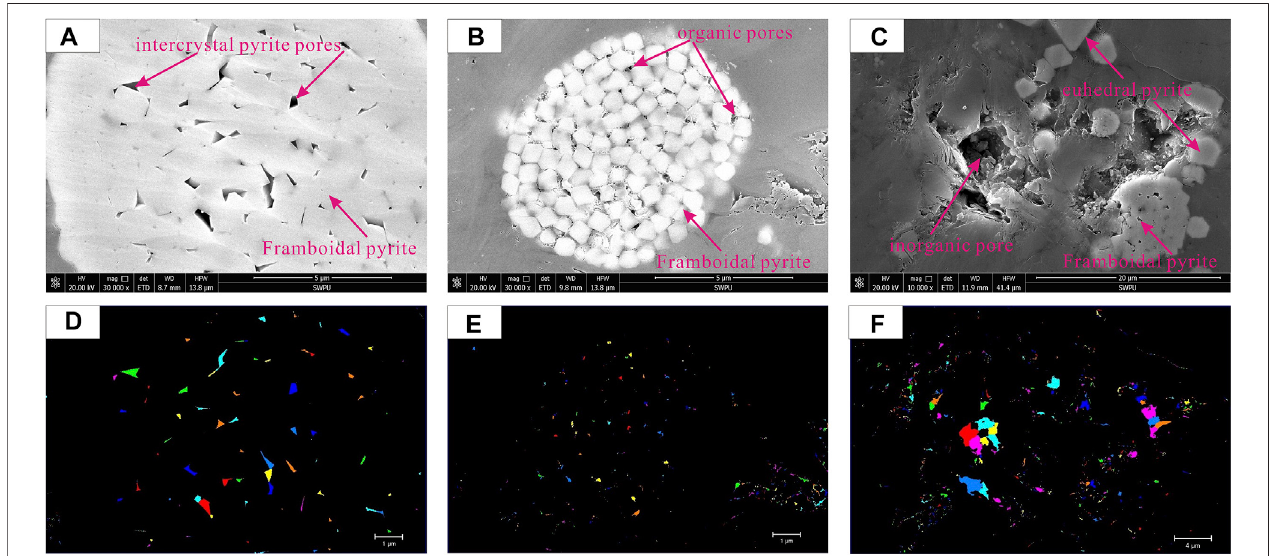
FIGURE 9 | Microphotographs showing pyrite and micropore development characteristics. (A) Intercrystal pyrite pores are developed in framboidal pyrite (FmPy), 3786.85 m,L208well; (B) intercrystalpyriteporesandorganicporesaredevelopedinframboidalpyrite,3830.40 m,L208well; (C) inorganicpores,euhedralpyrite,and framboidal pyrite, 3840.43 m, L208 well; (D) pore morphology and distribution of graph a; (E) pore morphology and distribution of graph b; (F) pore morphology and distribution of graph (C)